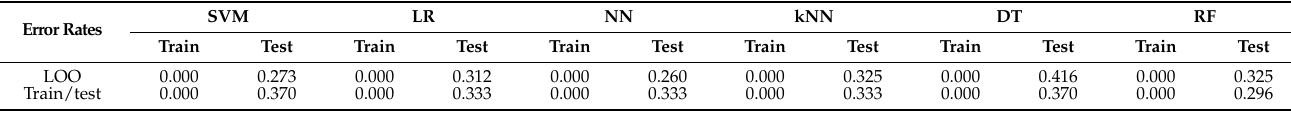
Table 2. Error rates for the OrigD dataset (default values).